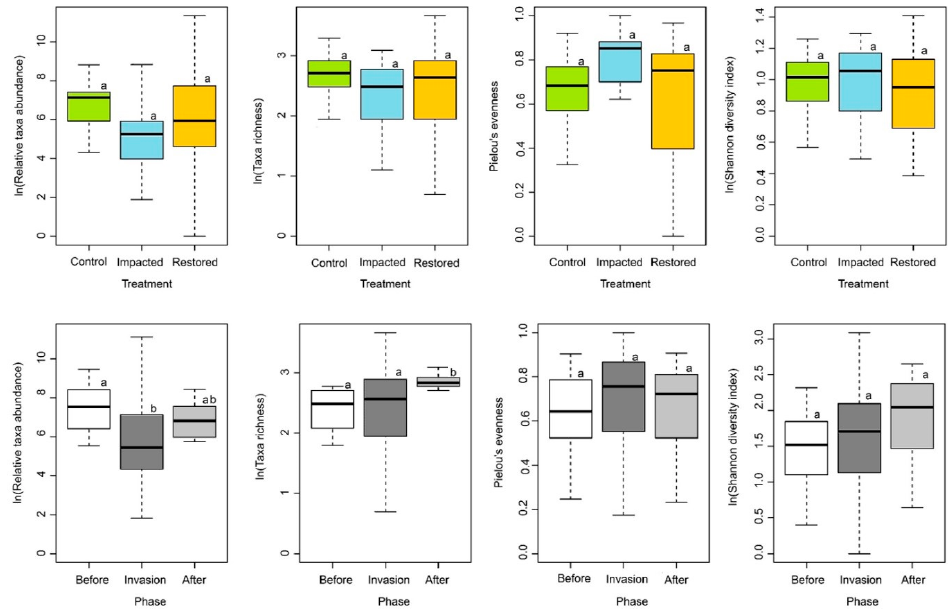
Figure 2. Epilithic algae diversity indices between treatments and invasion phases. Box plots represent median values with interquartile range. Whiskers represent maximum and minimum values. Different lowercase letters represent significant differences. Control—open water; impacted— 100% Salvinia molesta; restored— Salvinia molesta and Cyrtobagous salviniae treatments; before— “before” invasion phase; invasion—“during” invasion phase; after—“after” biological control phase. Epilithic algae biodiversity indices data (mean and standard deviation) per week are presented in Figure S1.